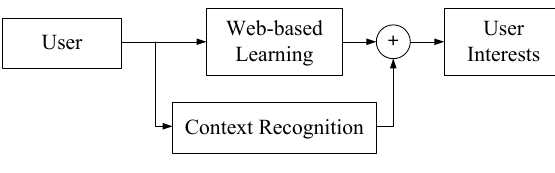
Fig. 2. Block diagram of image enhancement processes